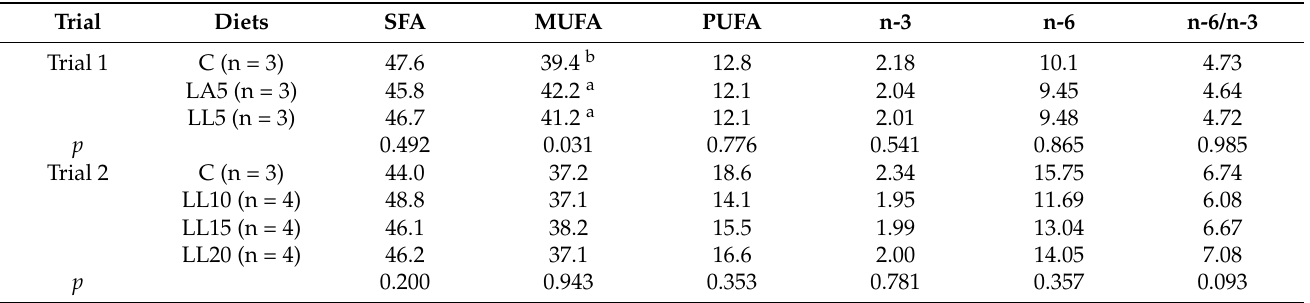
sources of protein diets, the results were very similar to those of the control diet. Table 6. Groups of SFA, MUFA and PUFA (g/100 g identified FA) in LM of lambs affected by diets in trials 1 and